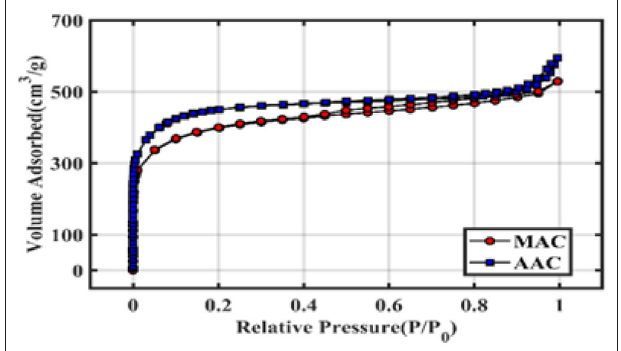
FIGURE 2 | Nitrogen adsorption-desorption isotherm curve for MAC and AAC.